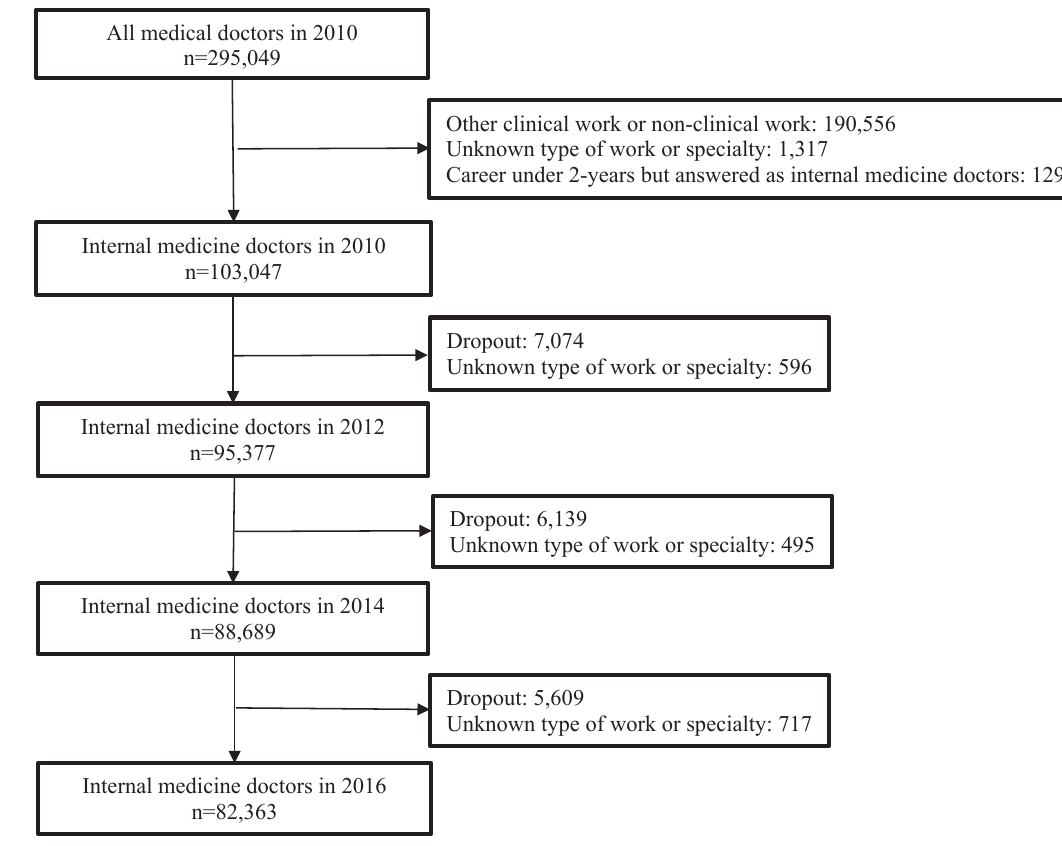
Fig. 1 Flow chart of the study